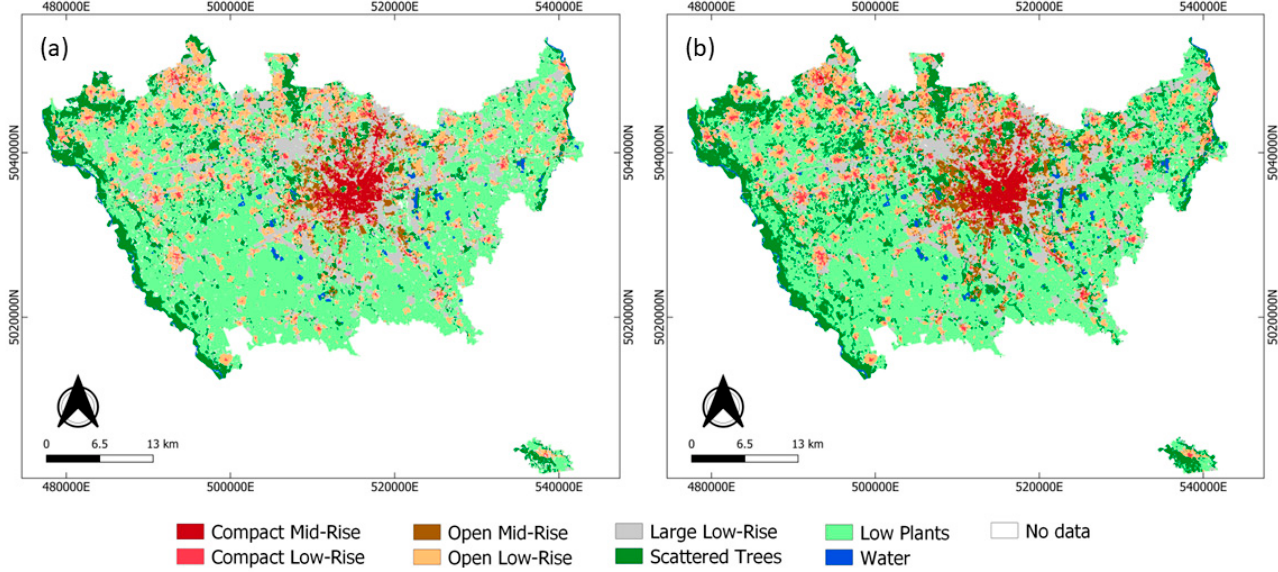
Figure 7. The two resulting LCZ maps obtained from Landsat 8 imagery classification: ( a ) before improvement; ( b ) after improvement. CRS: WGS84/UTM zone 32N. Table 3. Accuracies of the LCZ classification output, before and after classification improvement.